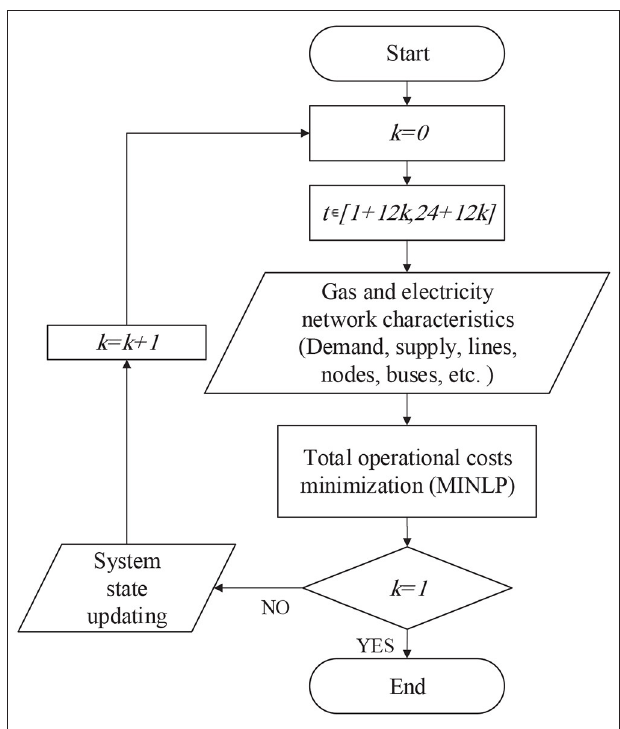
FIGURE 1 | Rolling planning structure of the gas and electricity system model.